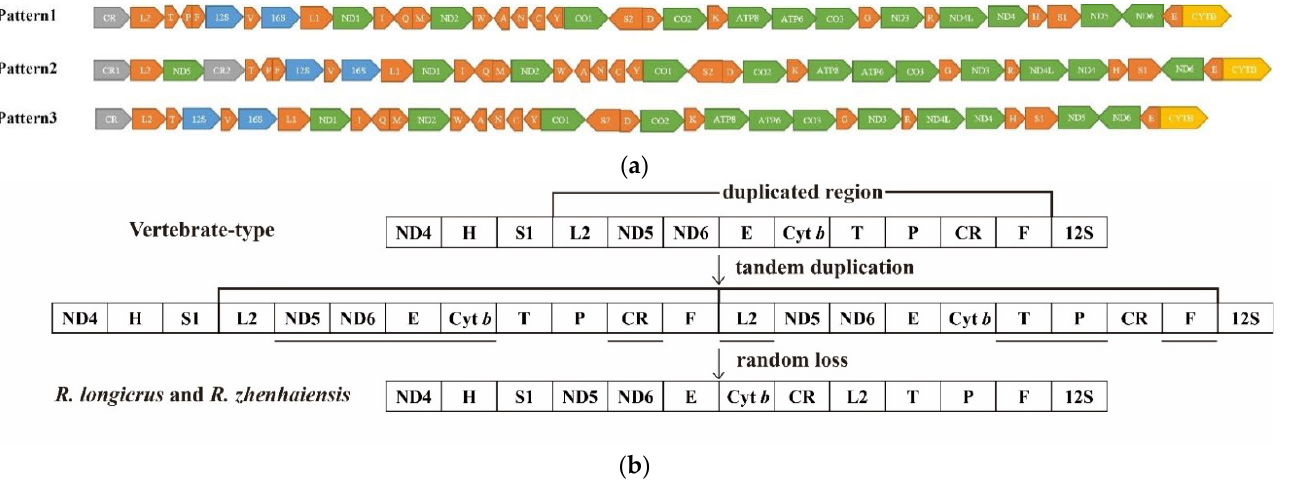
Figure 7. ( a ). Comparison of mitogenome arrangement of Rana . tRNAs are named using single-letter amino acid abbreviations. L1, L2, S1, and S2 represent tRNAs of Leu (UUR) , Leu (CUN) , Ser (AGY) , and Ser (UCN) , respectively. ( b ). A model for gene reorganization in the mtDNA genomes of R. longicrus and R. zhenhaiensis . After tandem duplication of a gene region is produced, multiple deletions of redundant genes occur. The gene order of R. longicrus and R. zhenhaiensis is the same as neobatrachians’ general one.